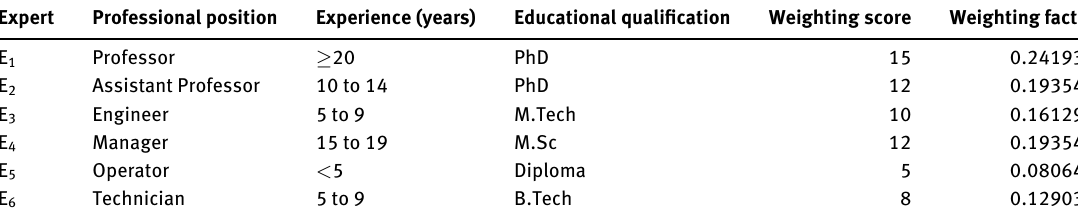
Table 5: Weighting Factors for Six Experts.